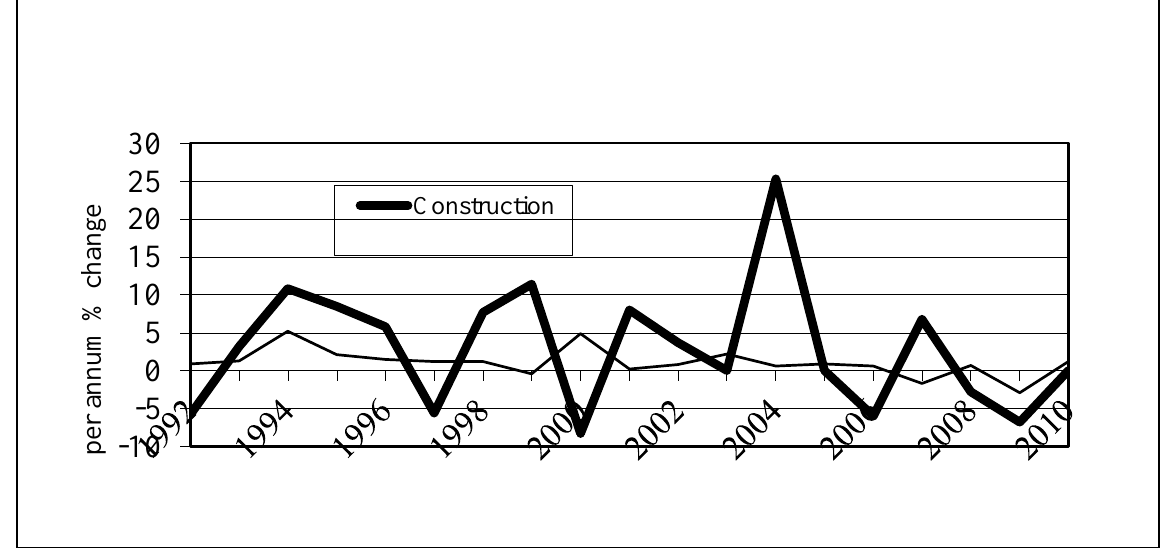
Figure 3 Productivity growth, construction and whole economy, New Zealand 1991 to 2010 Source: Statistics New Zealand 2012, Industry productivity